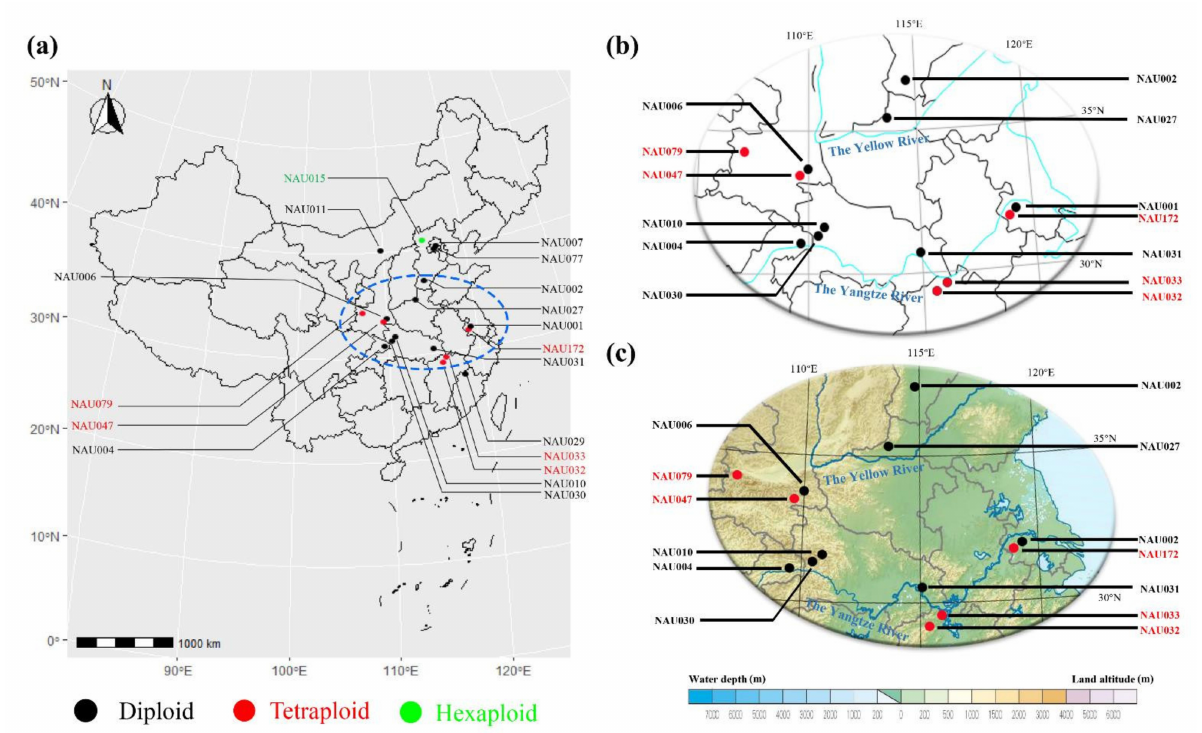
Figure 2. Geographic distribution of related Chrysanthemum accessions: ( a ) whole geographic dis- tribution map of Chrysanthemum accessions; ( b ) a detailed map of the blue dotted area; ( c ) detailed topography amplitude map of the blue dotted